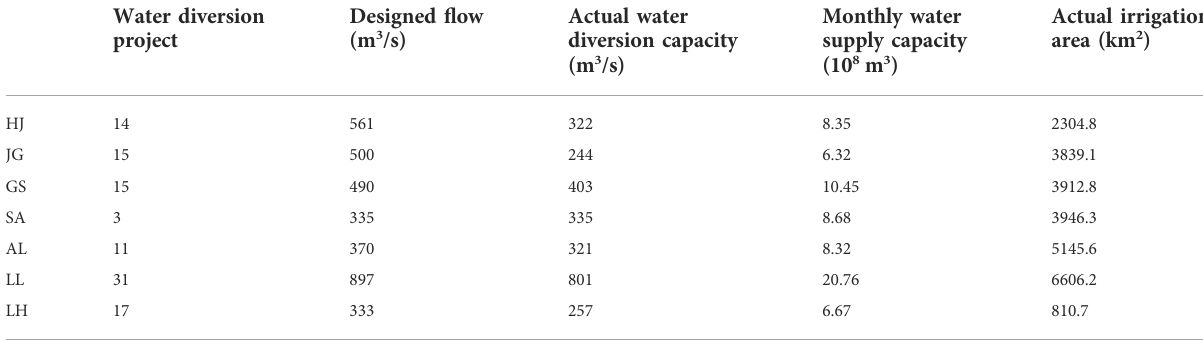
TABLE 5 Water diversion and water lifting projects in the lower Yellow